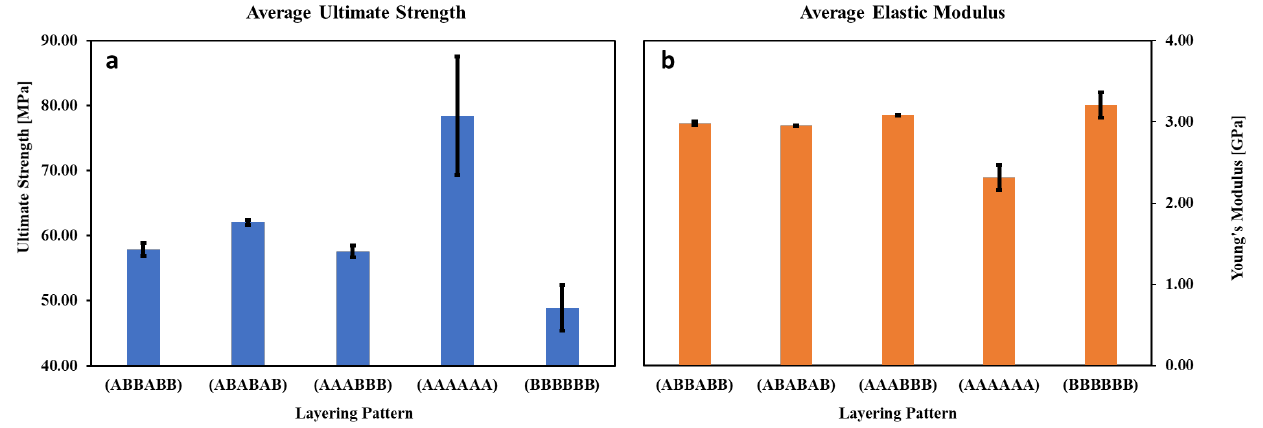
Figure 12. Average ( a ) ultimate tensile strengths and ( b ) elastic moduli of single and multi-material parts made from A — ULTEM 9085 + B — ULTEM 9085CF.